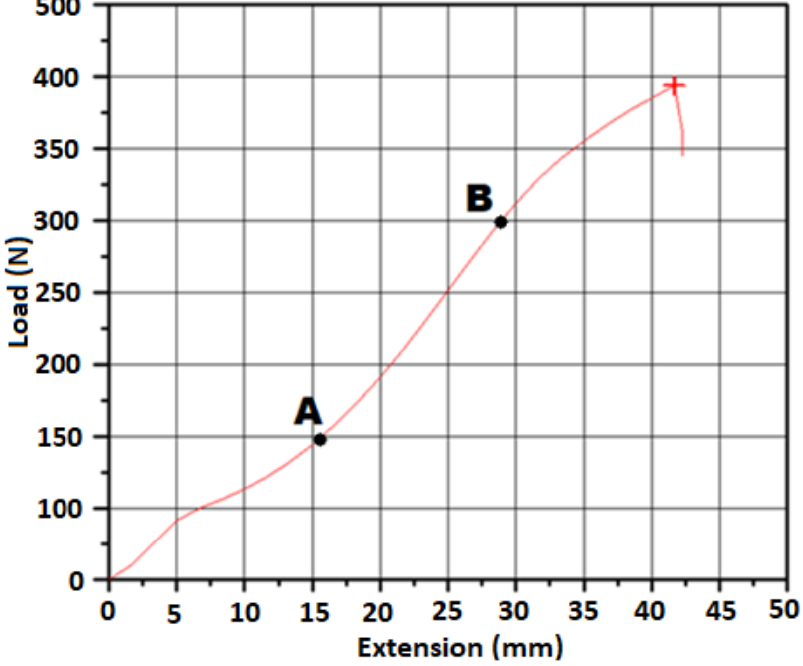
Figure 5. The exemplary graph for calculation of the Young’s modulus (sample 1, warp).